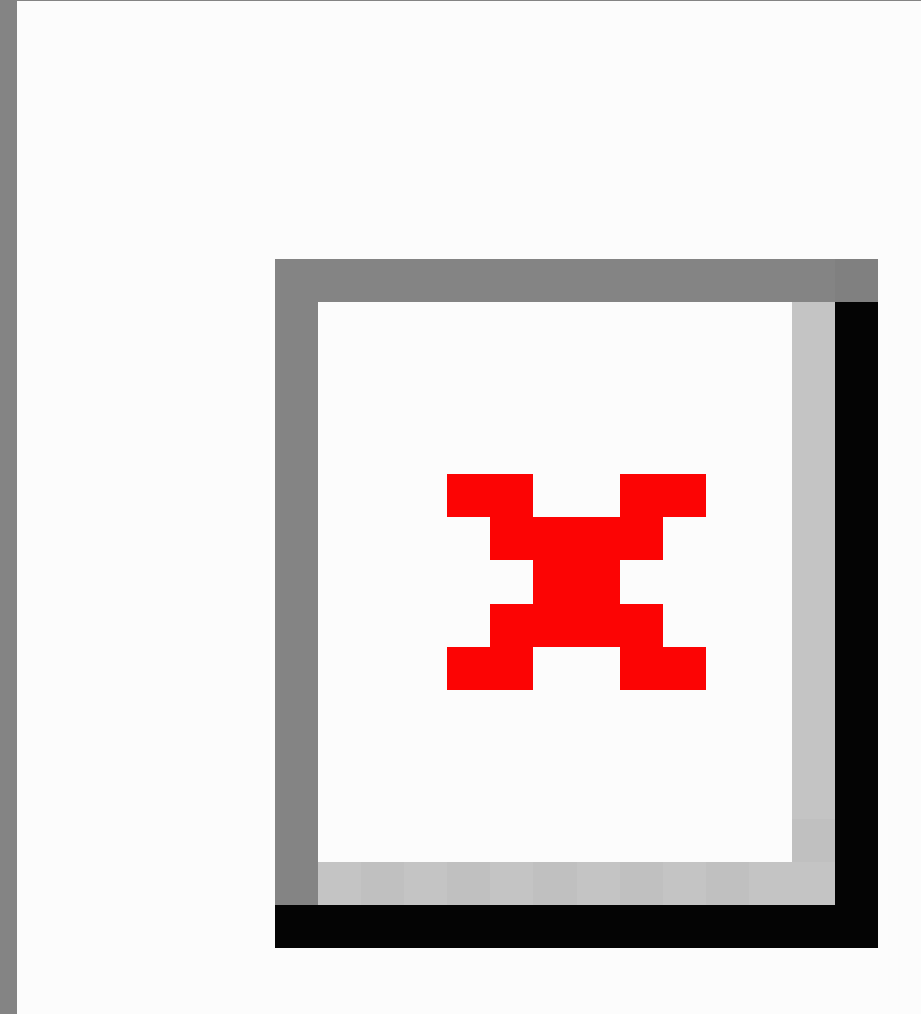
Figure 3. MDS diagram of altmetric